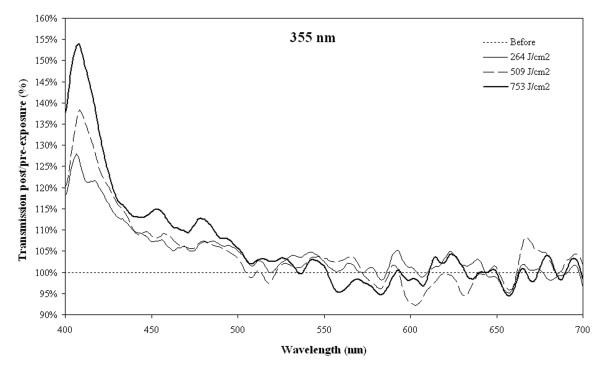
Transmission changes after 355 nm. Changes in transmission after irradiation of a 72 year old human donor lens with a 355 nm pulsed laser. Each graph represents a 60 minute exposure duration. This was the only lens that showed a dose-response photobleaching after exposure to 355 nm.